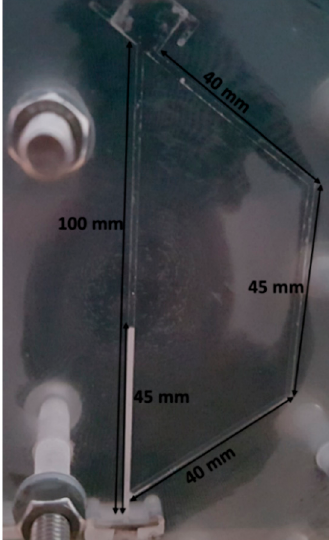
Figure 3. Example of solid inventory measurement with static bed height of 45 mm as determined by ImageJ. In this case 45 mm static bed height corresponds to 20% of surface percentage occupied by the particles out of the whole system surface. Therefore, the solid inventory in the system was estimated to be 20%.